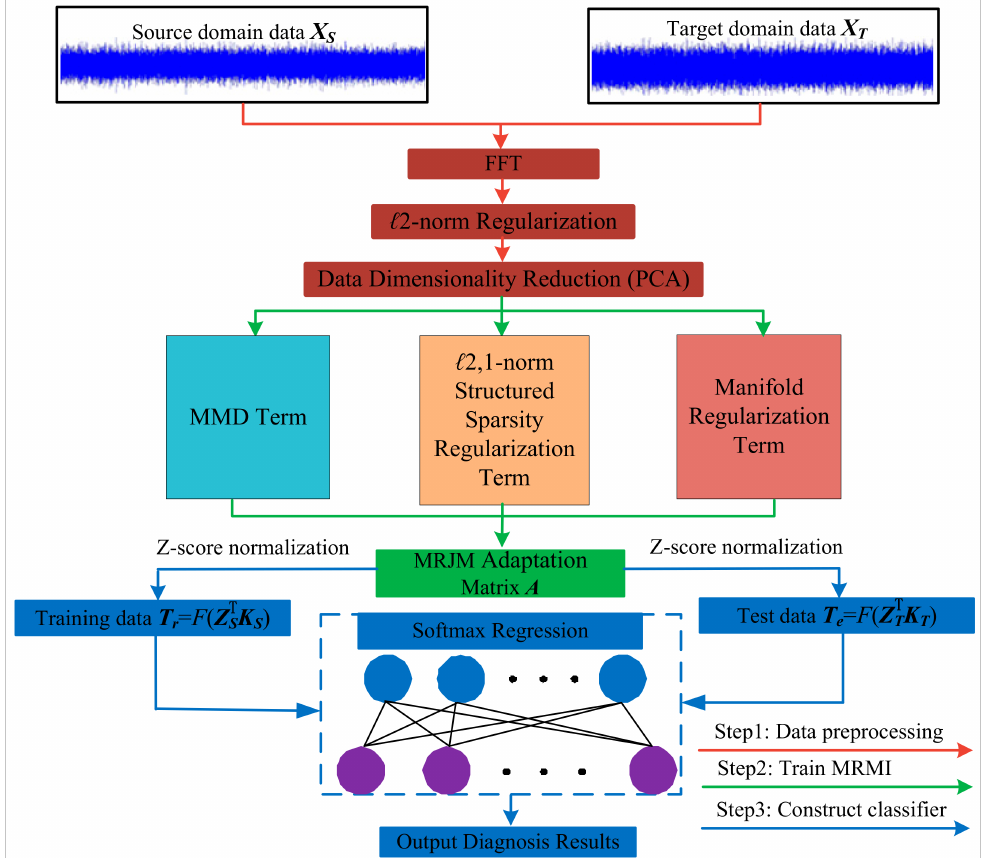
Figure 2. The framework of